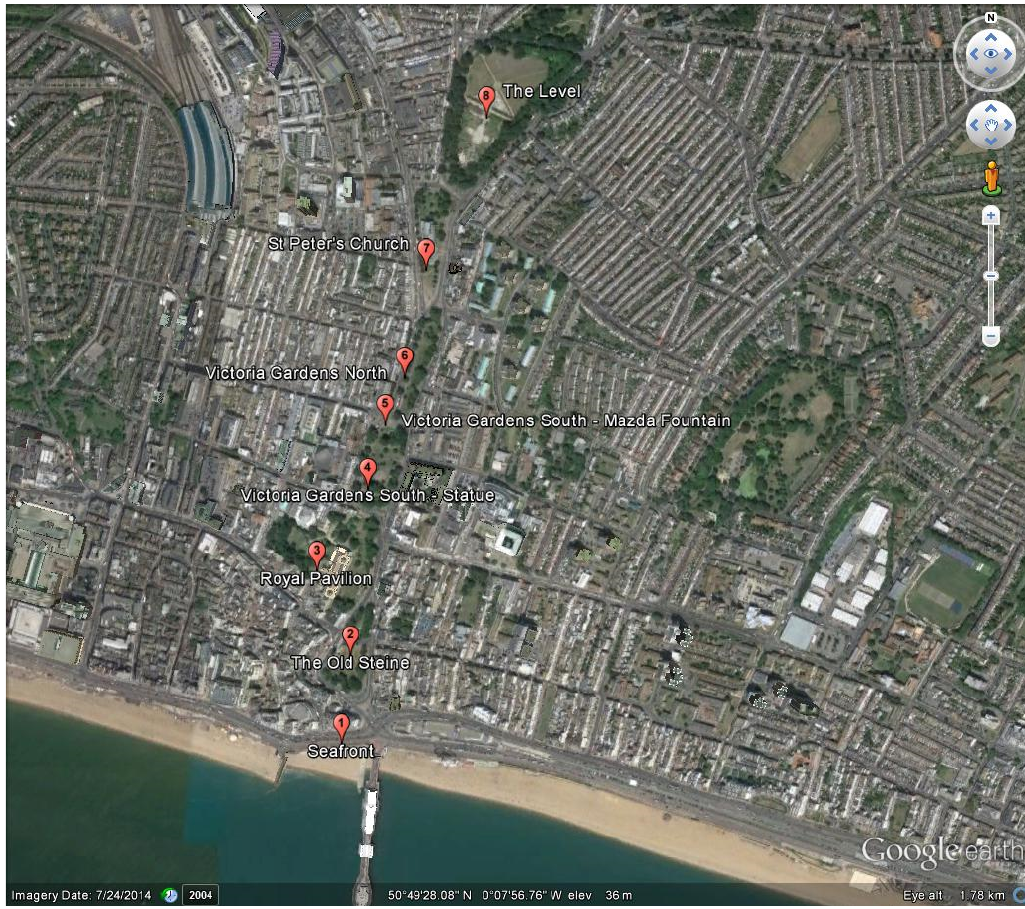
Figure 2: The eight locations selected for the soundwalk and the binaural recordings